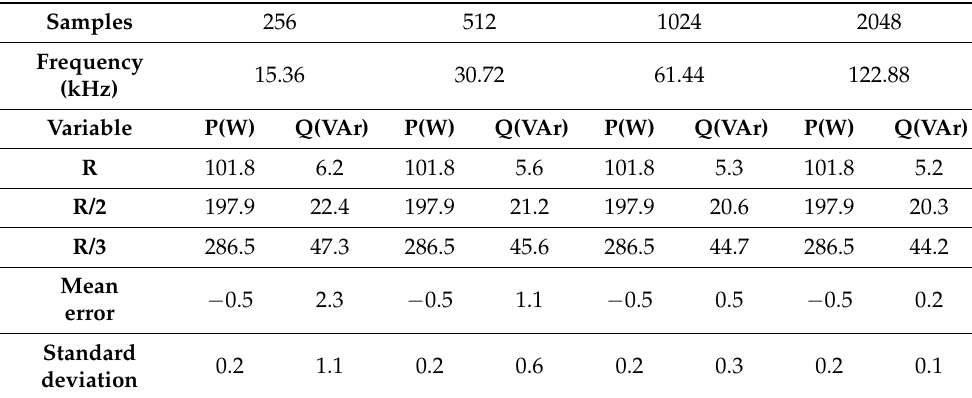
Table 10. Powers evaluated by CPT for RL loads considering 256, 512, 1024, and 2048 samples.